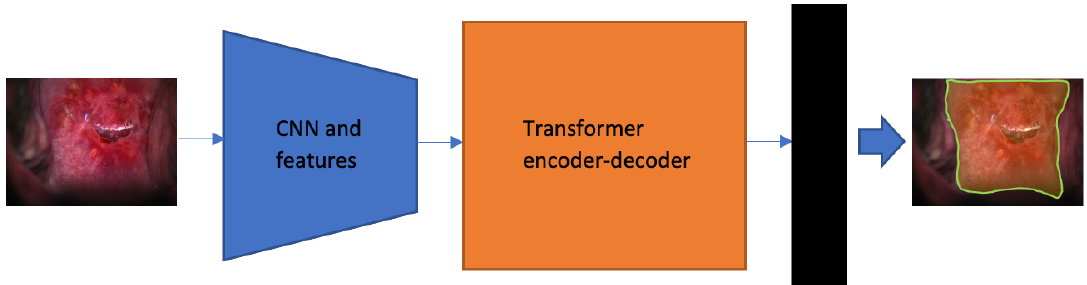
Figure 3. The DeTr-based model we constructed for segmentation. The box in black color represents the used mask head that is a multi-perceptron-layer (MPL) consisting of an 8-channel 1 × 1 fully convolutional module. In all, 3 encoder layers, 3 decoder layers, and 4 attention heads are used in the transformer units, and due to our target quantity limitation, we reduce the number of object query slots to 20 compared to that used in [13].